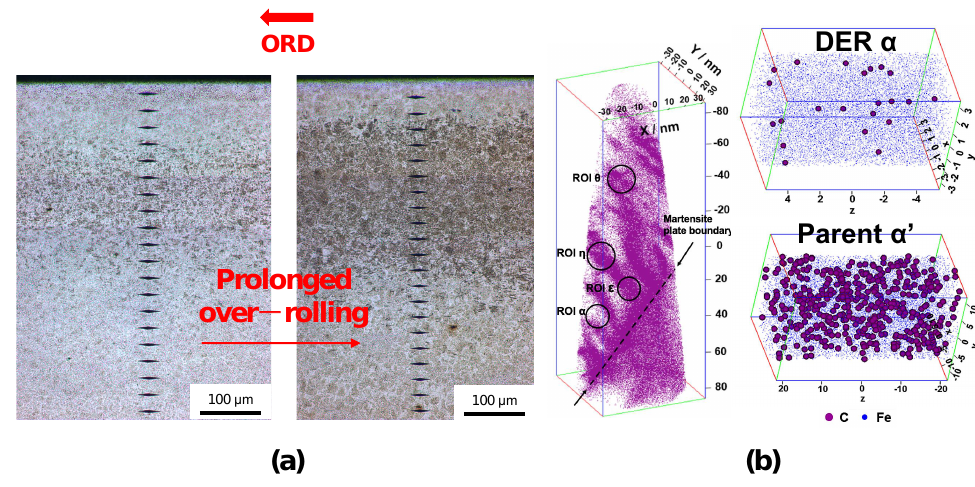
Figure 4. Formation of DERs. ( a ) Optical images showing the development of DERs in a circumferential section with prolonged over-rolling. The RCF tested was conducted on 100Cr6 bearing steel with a contact pressure of 3.3 GPa at 70 ◦ C for 10 7 and 10 8 cycles, respectively. ( b ) APT investigation of DER microstructure. The images are adapted from ref.